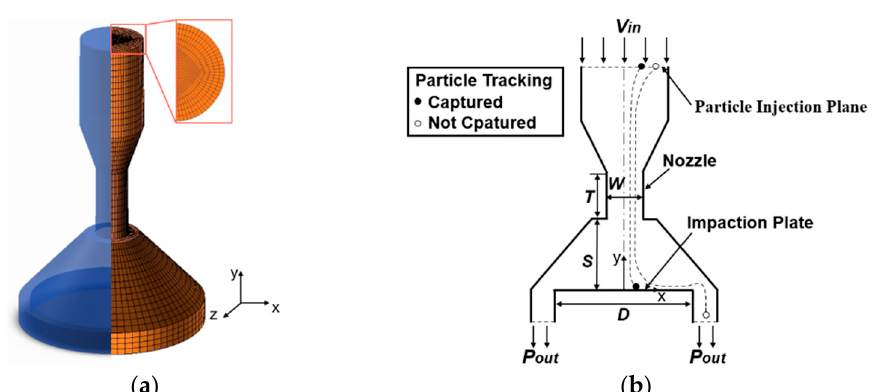
Table 1. Calculation conditions for CFD-DEM simulations.